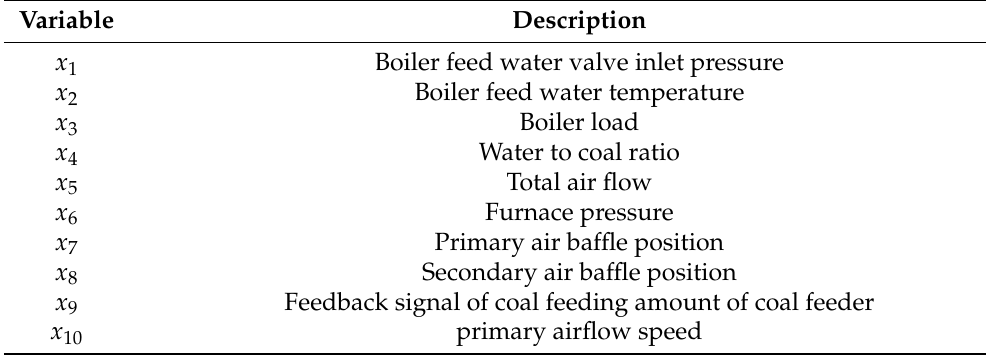
Table 4. Variables and description for boiler water wall over-temperature